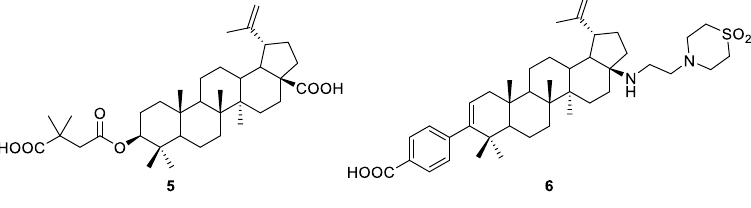
Figure 2. Structures of bevirimat 5 and BMS-955176 6 .